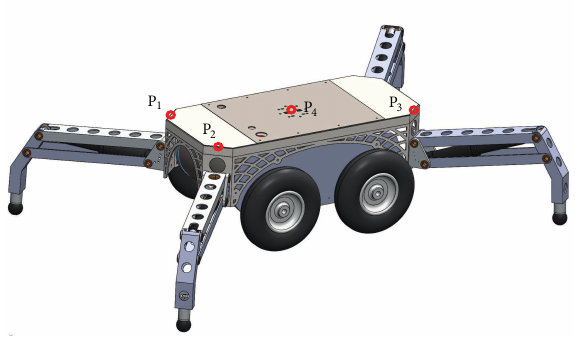
Figure A1. Experimental